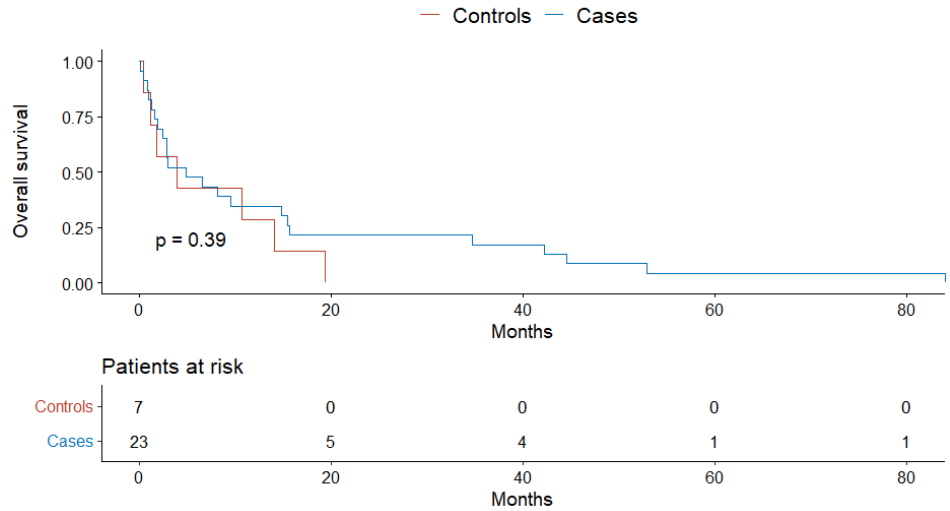
Figure 5. The overall survival of cases and controls with three or more comorbidities.